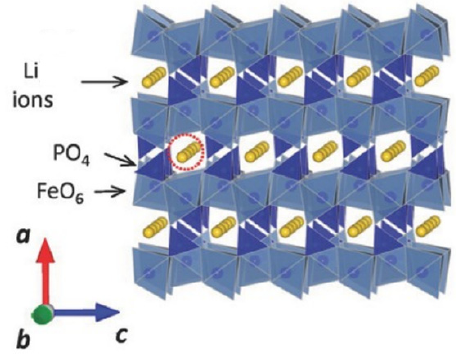
Figure 3. Crystal structure of LFP cathode [23].